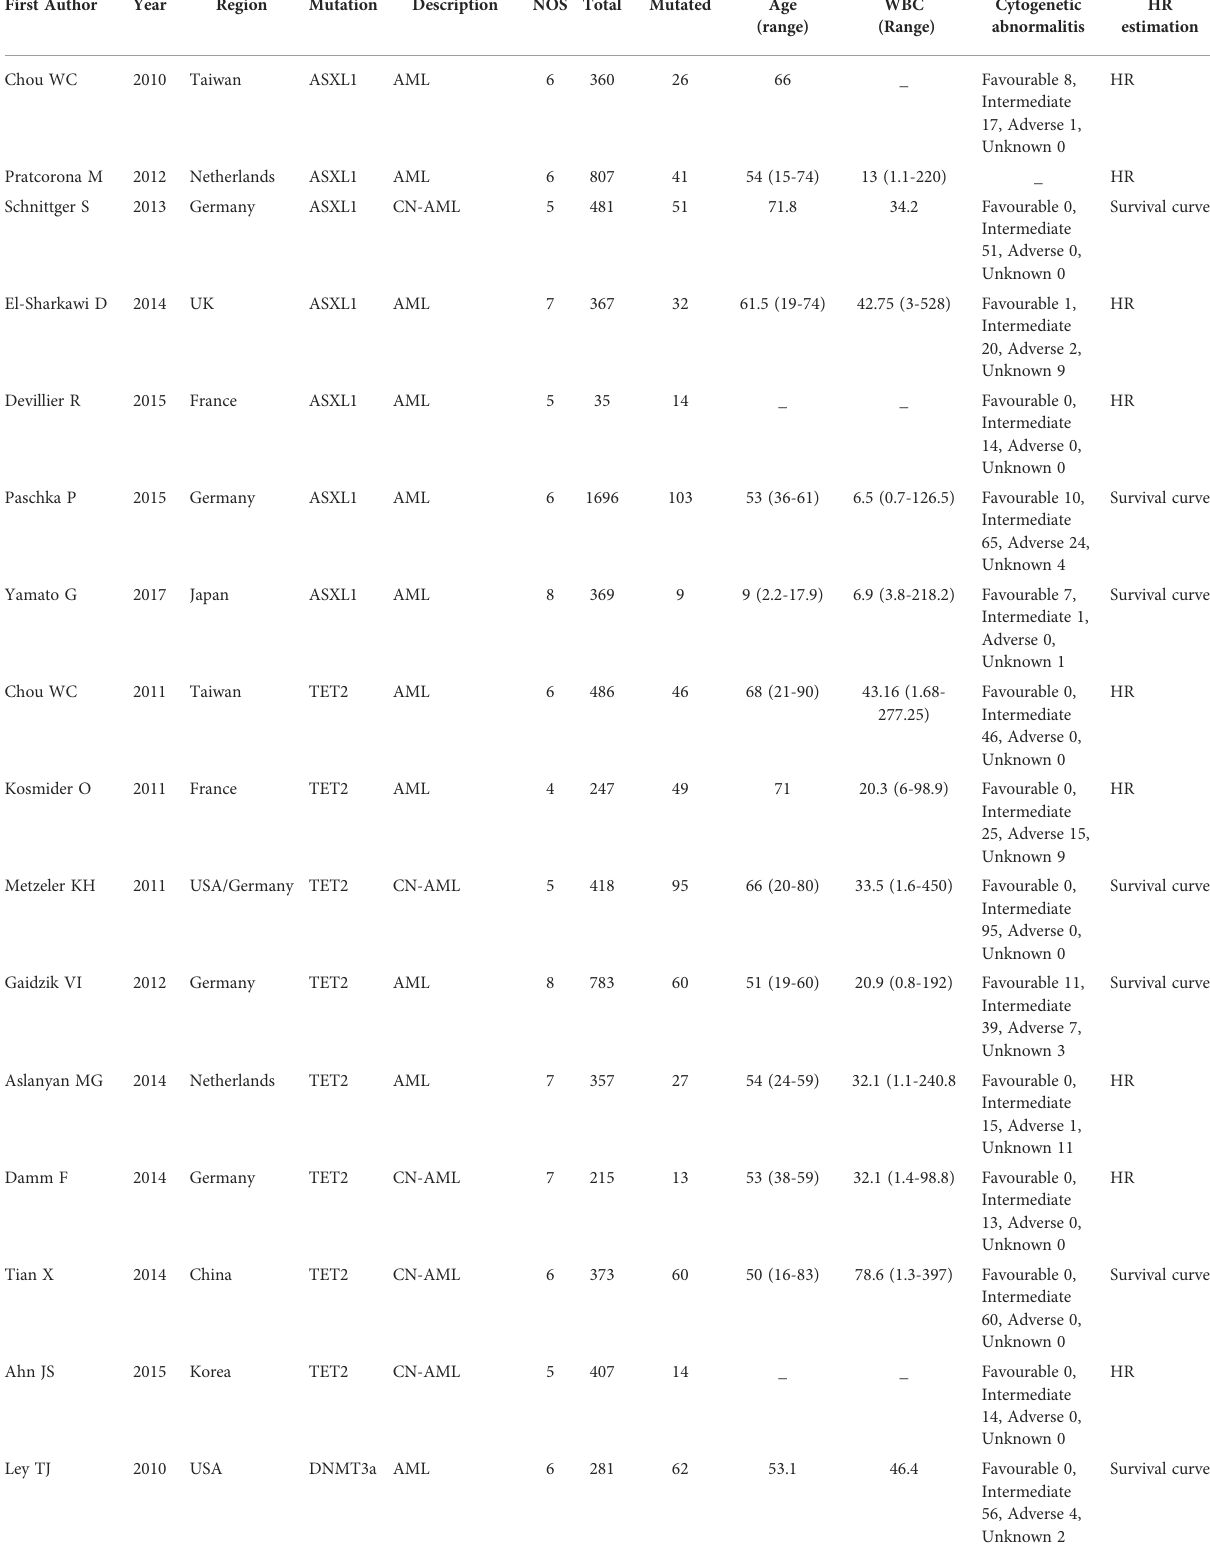
TABLE 1 Description of the studies included in the systematic